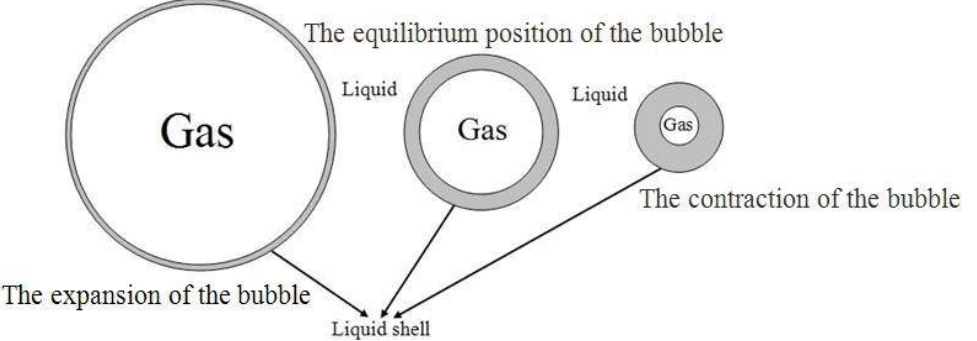
Figure 6. Schematic diagram of the cavitation bubble pulsation.